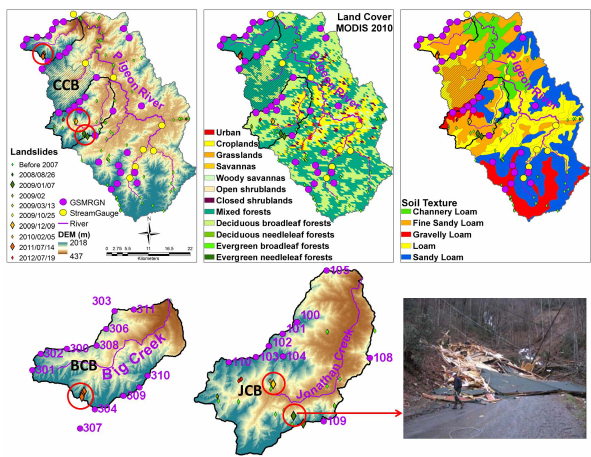
Fig. 1. Topography, major rivers and rain gauges over the Pigeon River Basin in North Carolina, USA. The Big Creek Basin (BCB) and the Jonathan Creek Basin (JCB) are marked, and the Cat- aloochee Creek Basin (CCB) used for hydrological verification is illustrated by shaded area. Simulated events of interest are marked using circles. The debris flow that occurred in the JCB on 7 Janu- ray 2009 destroyed a house completely (shown in the picture below, courtesy goes to Dr. Richard Wooten). Land cover and soil texture are also provided, indicating the spatially varying vegetation and soil types over the